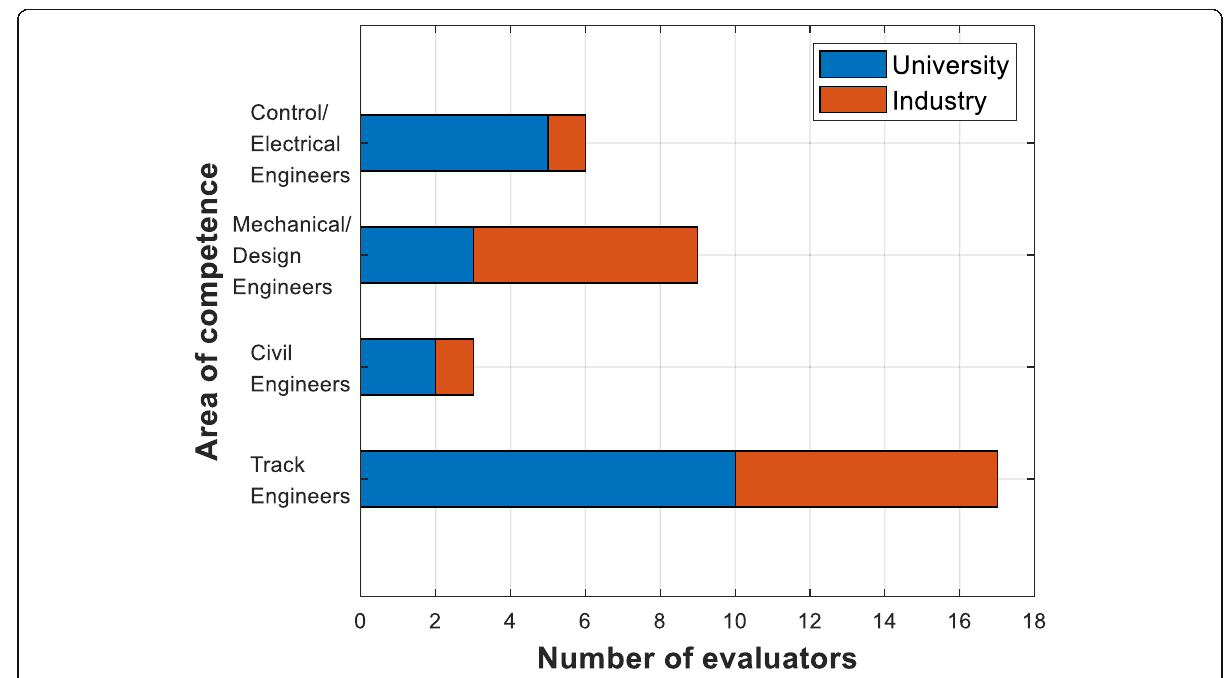
Fig. 2 Technical profile of evaluators showing diverse